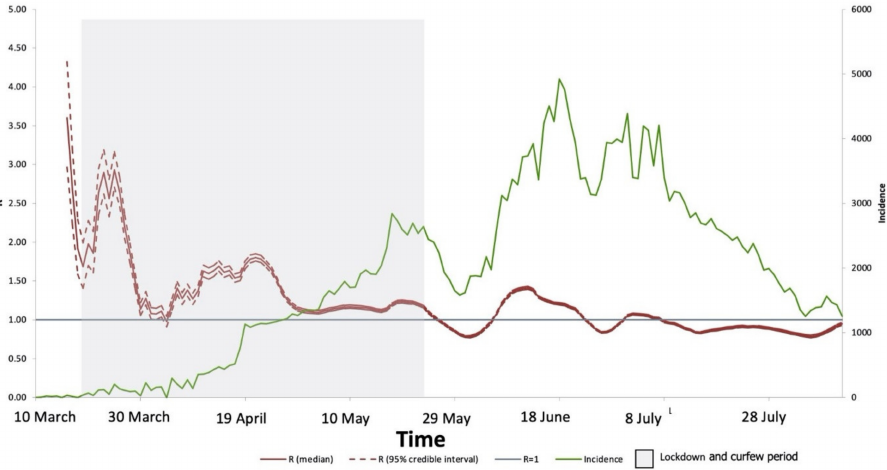
Figure 4. The estimated instantons reproduction number (R t ), using EpiEstim package and model using gamma distribution. Cases were detected for 155 days in Saudi Arabia. The average R-value from 10 March to 11 August 2020, was 1.23. The red line shows the average median of R, the dashed red line shows the confidence intervals, while the green line shows the incidence of cases reported, the grey area represents the time of lockdown, while the blue line represents the R =